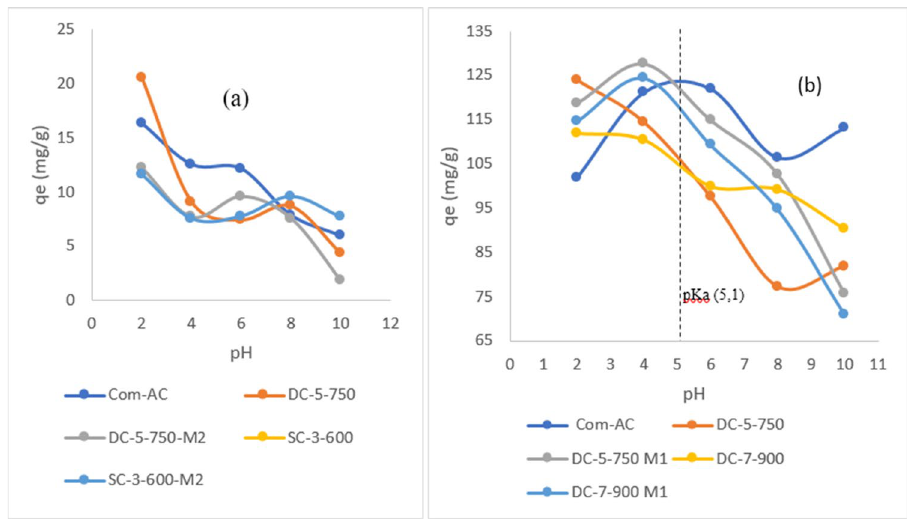
Figure 20. Effect of pH solution on nitrate ( a ) and MR ( b )